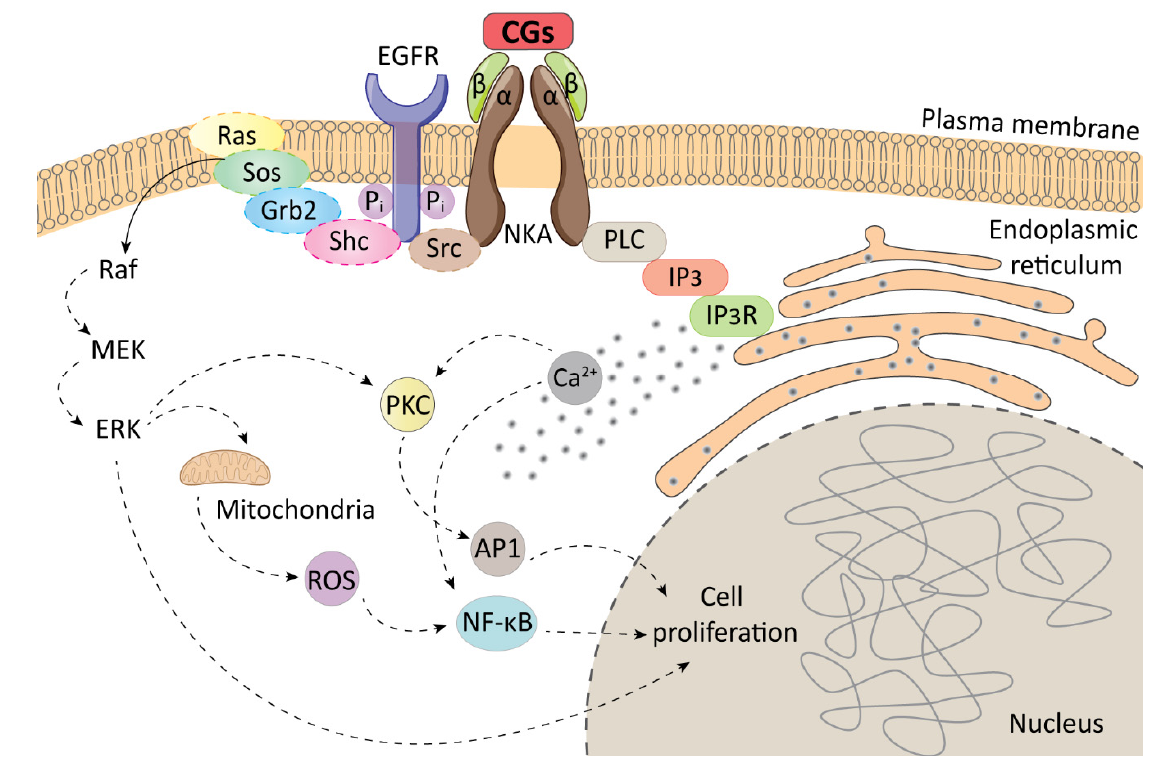
Figure 2. A schematic representation of the Na + /K + -ATPase (NKA) signalosome. Adapted from [45]. AP1–transcription factor; CGs–cardiac glycosides; EGFR-epidermal growth factor receptor; ERK- extracellular signal-regulated kinase; Grb2- growth factor receptor-bound protein 2; IP 3 –inositol triphosphate; IP3R–inositol triphosphate receptor; MEK-mitogen-activated protein kinase kinase; NF- κ B-nuclear factor kappa-light-chain-enhancer of activated B cells; PKC–protein kinase C; PLC–phospholipase C; Raf–serine/threonine kinase; Ras–rat sarcoma protein; ROS–reactive oxygen species; Shc–Src homology 2 domain-containing transforming protein 1; Sos–son of sevenless; Src-non-receptor tyrosine kinase.